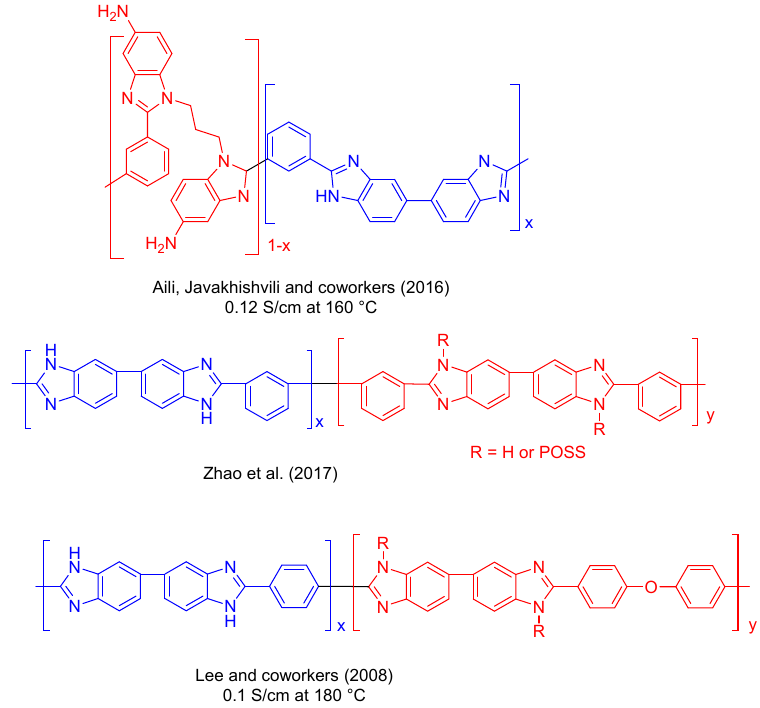
Figure 11. Di ff erent copolymers of PBI. POSS, polyhedral